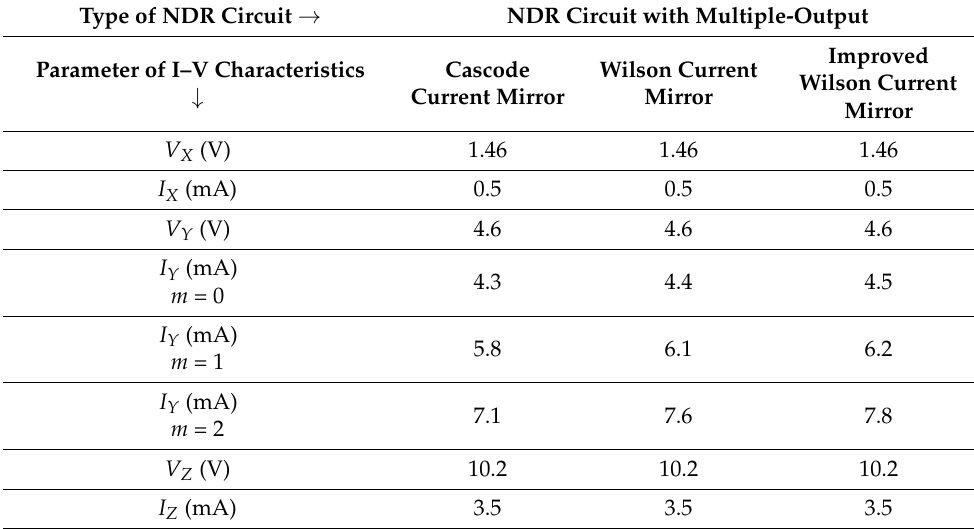
Table 1. Simulated parameters of current-voltage characteristics for different two-terminal NDR circuits ( T 0